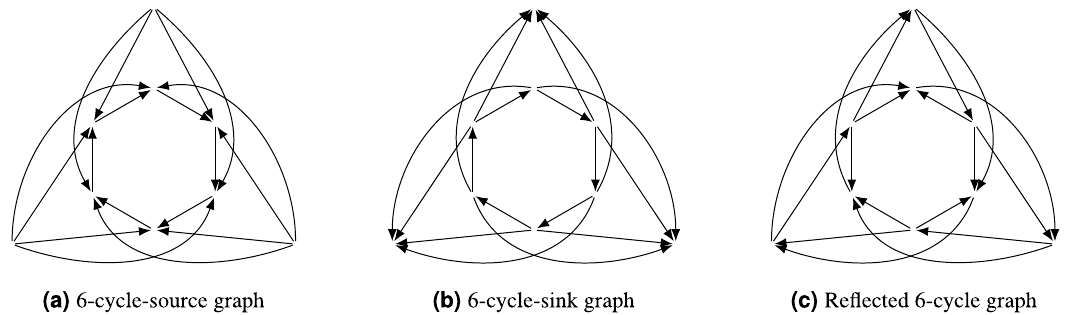
Figure 10. The 6-cycle-source graph ( a ) and its reversal, the 6-cycle-sink graph ( b ), do not contain MP and yet are not preference-potential. The reflection of either game in either player gives the Reflected 6-cycle graph ( c ), which is the unique 3 × 3 game which does not contain CO yet is not preference-zero-sum.